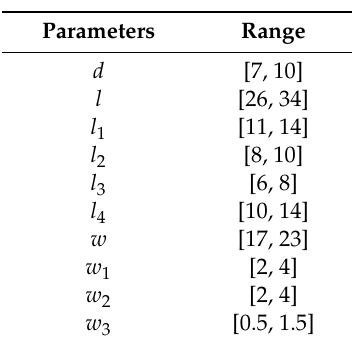
Table 1. Initial range of design parameters (units: